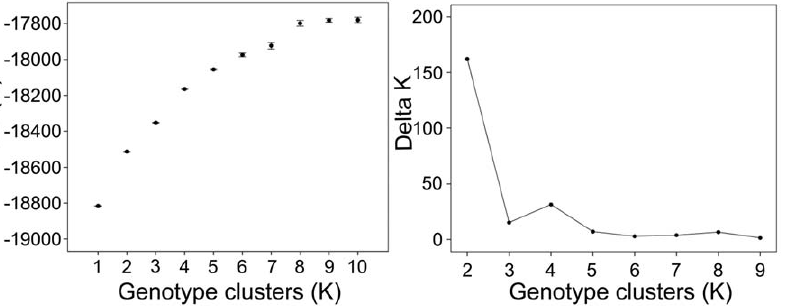
Figure 3. Inference of the number of genetic clusters (K) from STRUCTURE simulations for Chinese Frankliniella occidentalis populations. The likelihood of the data given K [ln P(D); left] and D K ([51]; right) are plotted against the number of genetic clusters (K). Error bars represent standard deviations over ten runs.